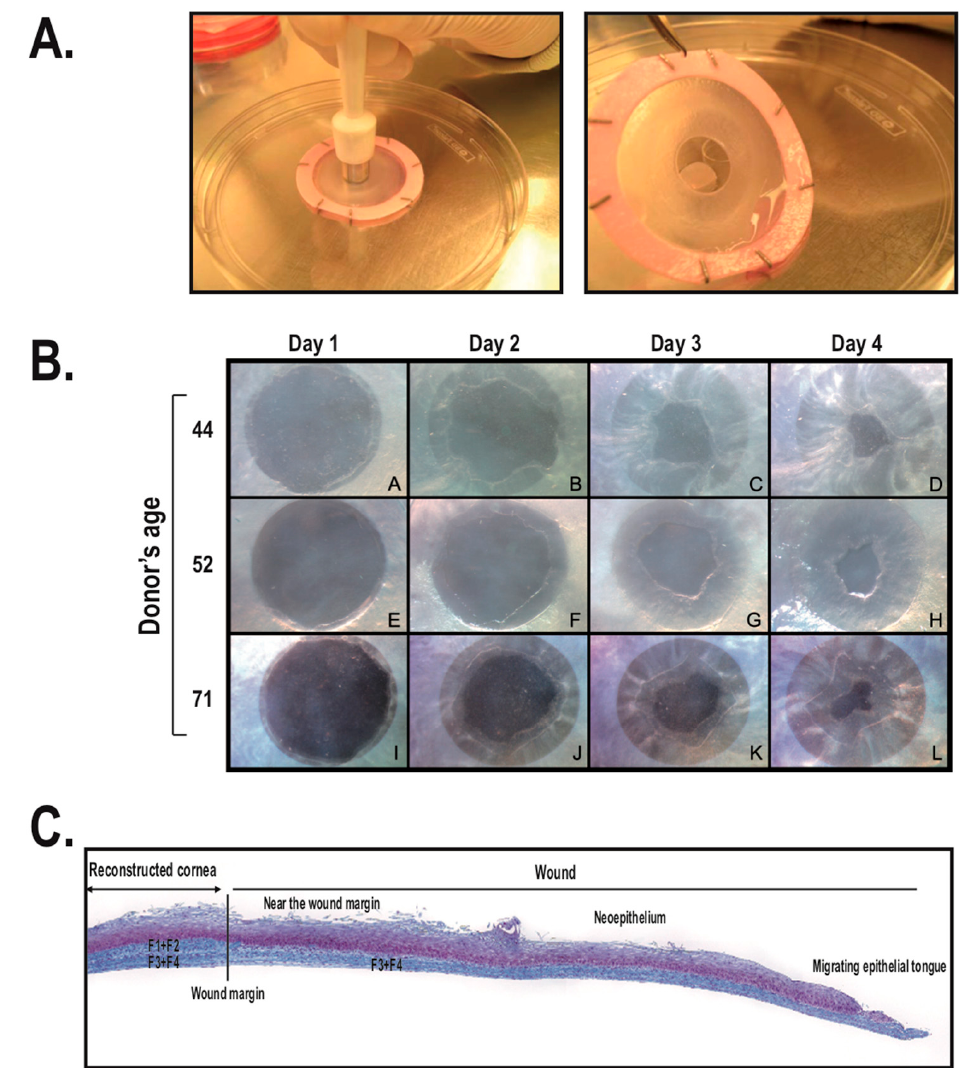
Figure 5. Production of wounds on human tissue-engineered corneas. ( A ) The reconstructed cornea is wounded using an 8 mm biopsy punch. ( B ) Closure of wounds on tissue-engineered corneas produced using HCECs isolated from the eyes of three different donors (44, 52, and 71 years old). Closure of the wounded epithelia was followed from 1 to 4 days after corneal injury. ( C ) Composite image showing a complete view of the wounded tissue-engineered human cornea 3 days following corneal damage (sections were stained with Masson’s trichrome; cells are pink and collagen is bluish). The wound margin created by the biopsy punch is indicated. F1 + F2: initial fibroblast sheets present in the reconstructed cornea prior to wounding. F3 + F4: supplementary fibroblast sheets added following wounding of the tissue-engineered corneas (Figure adapted from Reference [173] with the permission of the journal Biomaterials).